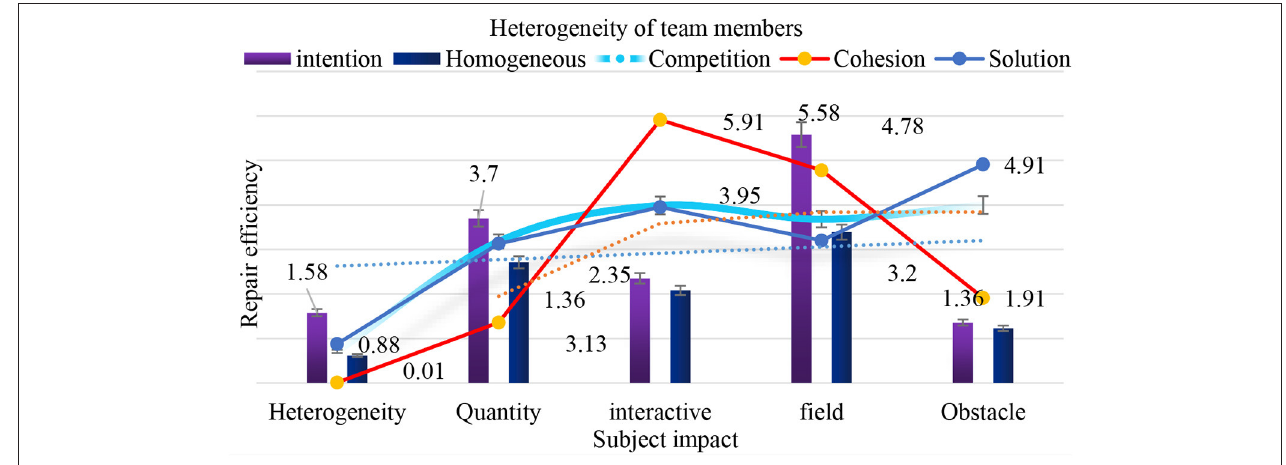
FIGURE 6 | Heterogeneity of team members.